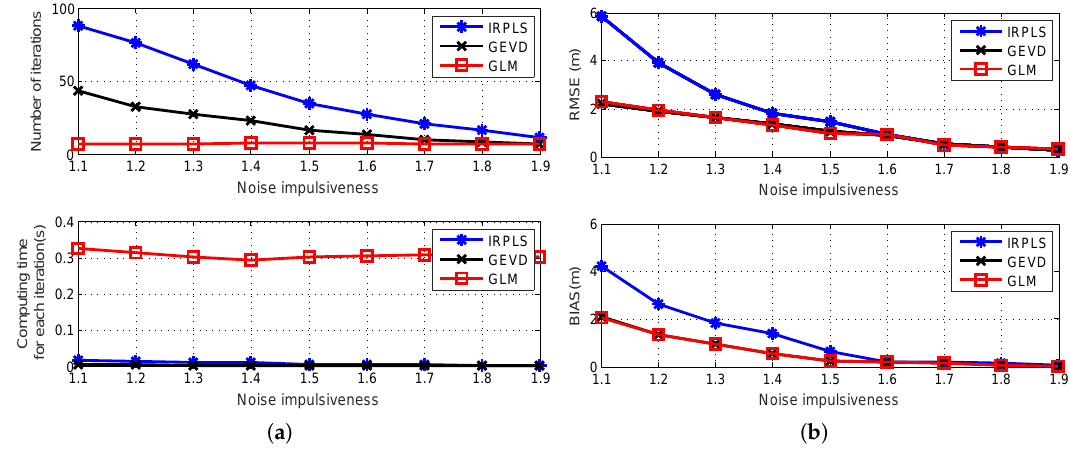
Figure 12. Scalability analysis for different levels of noise impulsiveness. ( a ) Number of iterations and computing time. ( b ) RMSE and bias